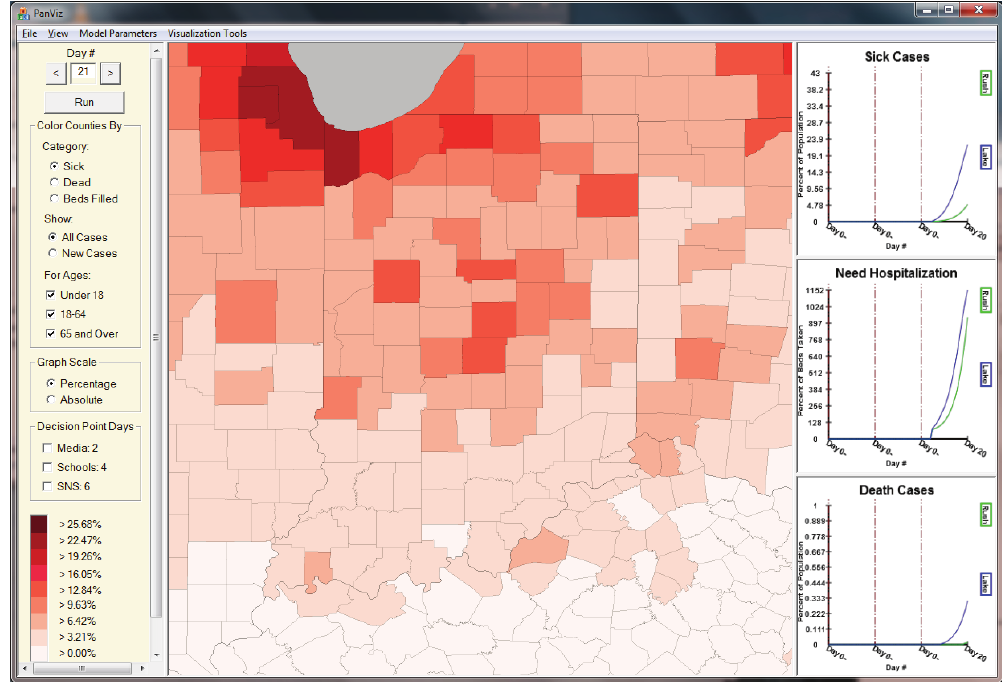
Figure 8: Here we illustrate the PanViz user interface. A user has simulated an outbreak originating in Chicago and has been exploring the spread of the infectious disease over space and time. This is day 21 of the simulation. The color of each county represents the percentage of the population that is ill. The plots on the right show the rate of spread (thus the rate of person-to-person connection), hospitalization, and death in user selected counties. Figure Courtesy of Ross Maciejewski from Figure 7 in [126]. For additional Infor- mation on the research it is derived from, see